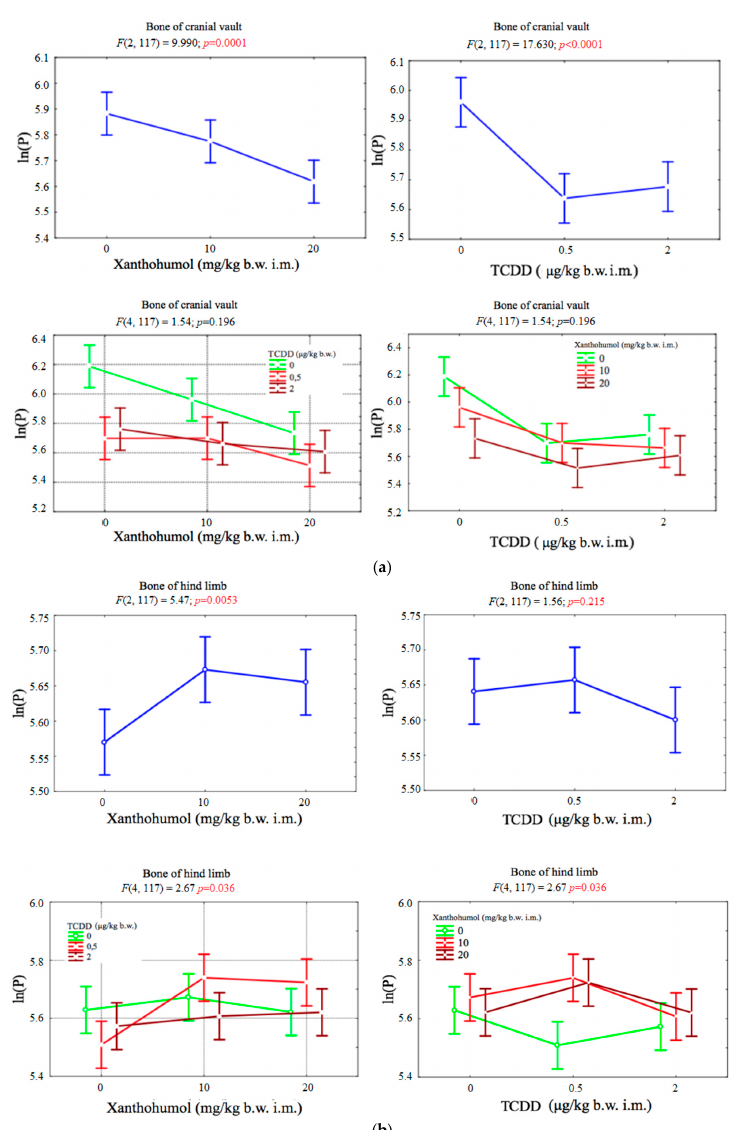
Figure 2. ( a ) Average phosphorus concentration (transformed variables) in the bone of the cranial vault, depending on the dose of TCDD and xanthohumol, and results of the significance test. Results are represented as mean ± SD. p ≤ 0.05 was considered statistically significant. Significant p value is highlighted in bold. ( b ) Average phosphorus concentration (transformed variables) in the bone of the hind limb, depending on the dose of TCDD and xanthohumol, and results of the significance test. Results are represented as mean ± SD. p ≤ 0.05 was considered statistically significant. Significant p value is highlighted in bold.